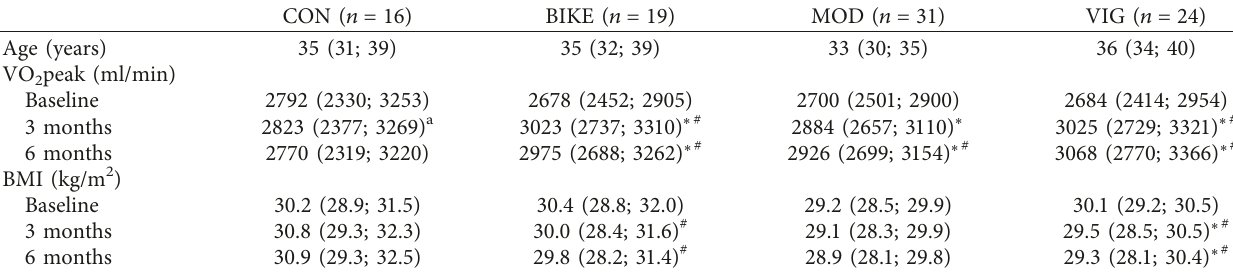
Table 1: Maximal aerobic capacity and body mass index at baseline and at 3 and 6